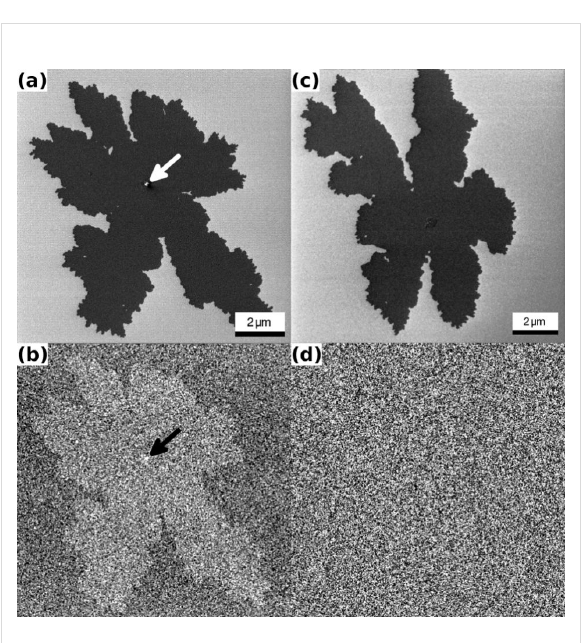
(b) BSHe image recorded simultaneously with (a). The different surface terminations can be distinguished.